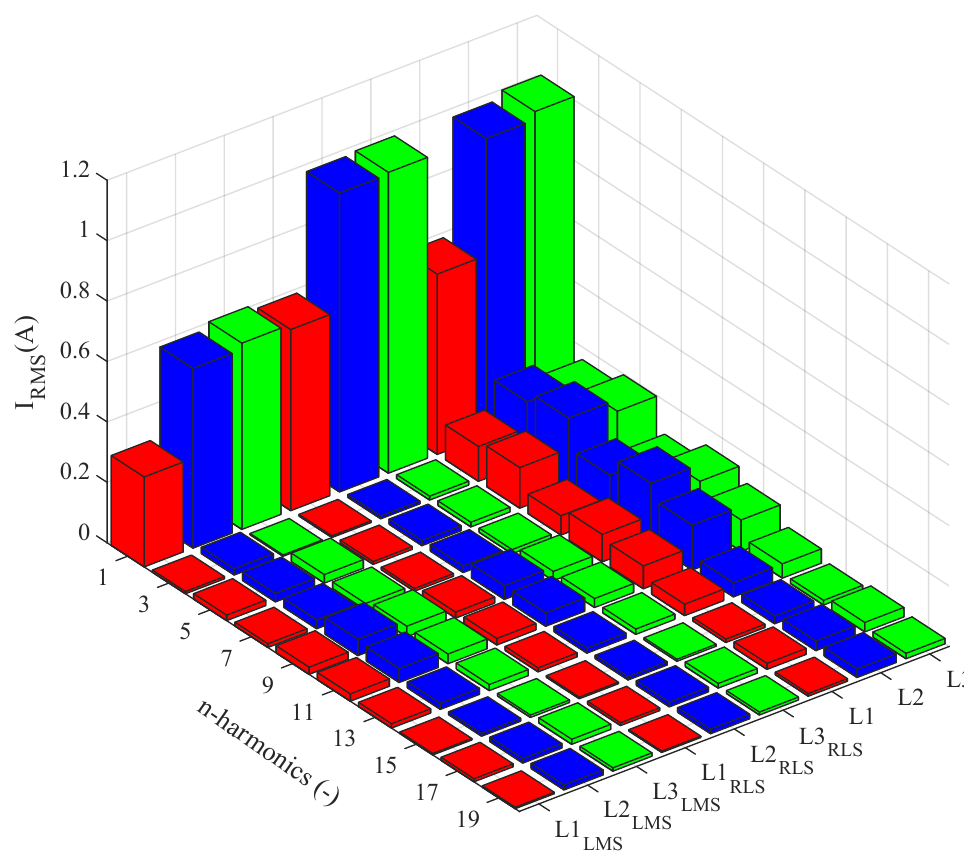
Figure 27. Idle run of test polygon; current spectra before and after application of the adaptive LMS and RLS algorithms.